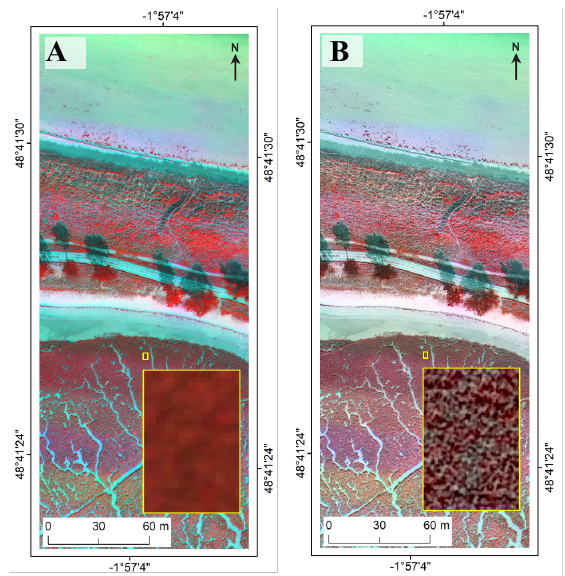
Figure 5. Red-edge (RE) unpansharpened (A); RE Gram- Schmidt pansharpened